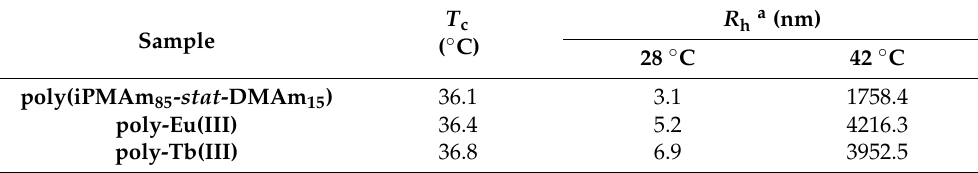
Table 2. A summary of cloud point ( T c ) and hydrodynamic radius ( R h